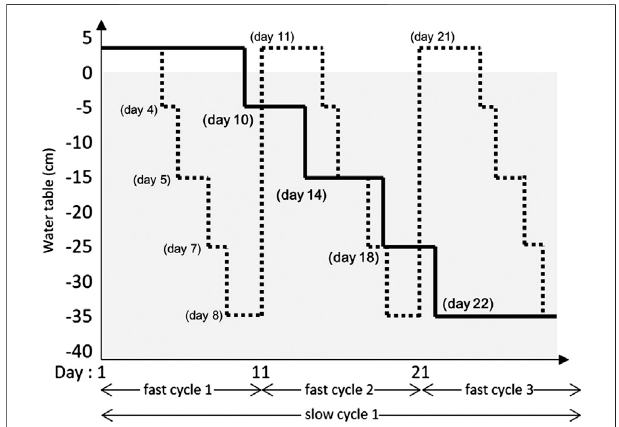
FIGURE 1 | Description of the slow fl uctuating (solid line) and the fast fl uctuating (dotted line) over 30 days. Positive water table values are levels above the peat surface (i.e.,